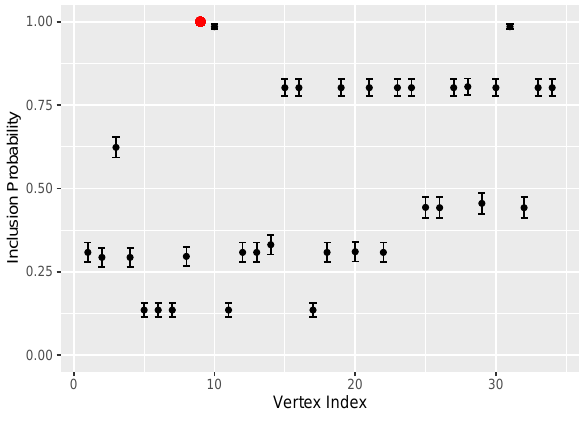
( e ) Inclusion probability in the local community of vertex 9 Figure 6. Inclusion probabilities in the local communities starting from five different seeds, which are represented by red dots. ( a ): vertex 1 (instructor). ( b ): vertex 34 (administrator). ( c ): vertex 5. ( d ): vertex 25. ( e ) vertex 9. The error bars depict twice the standard